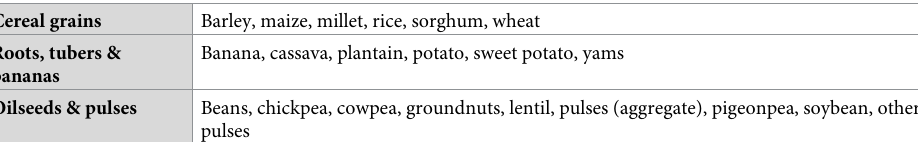
Table 1. Crops included in the analysis. Cereal grains Barley, maize, millet, rice, sorghum, wheat Roots, tubers &